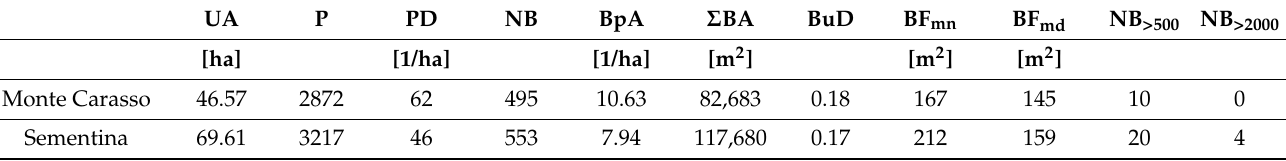
Table 1. Basic urban parameters of Monte Carasso and Sementina.